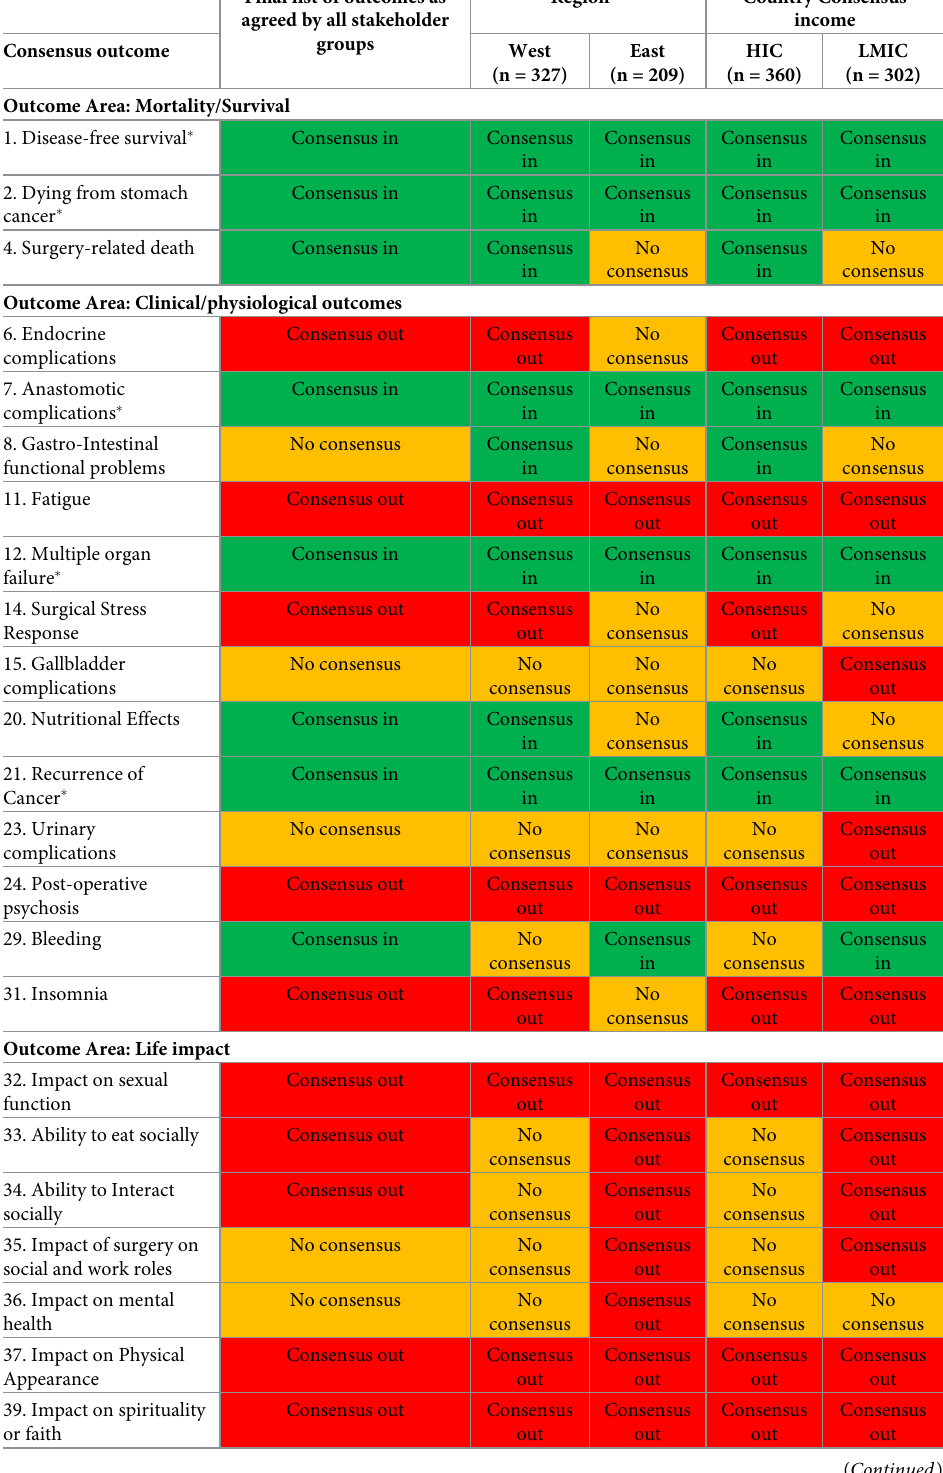
Table 5. Regional differences in consensus on outcomes voted for inclusion or exclusion from the COS by at least 1 subgroup. Final list of outcomes as agreed by all